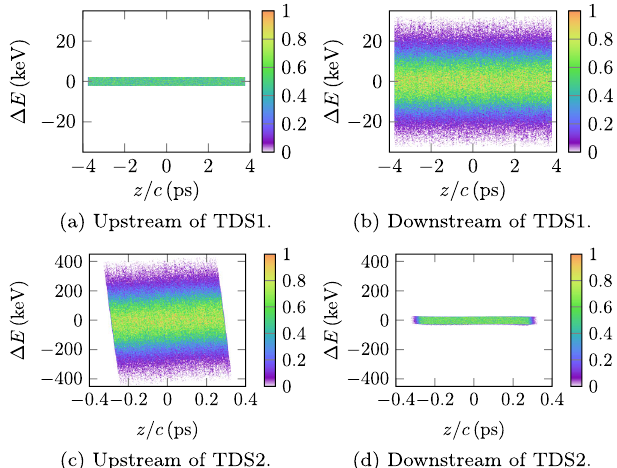
FIG. 3. Simulation of the longitudinal phase space after re- moving the correlated energy chirp: (a) Upstream of the first TDS, (b) directly downstream of the first TDS, (c) directly downstream of the bunch compressor and upstream of the second TDS, and (d) downstream of the second TDS. The axes scales change from (b) to (c) when bunch compression takes place. The bunch head is on the left, i.e., where z=c < 0 .